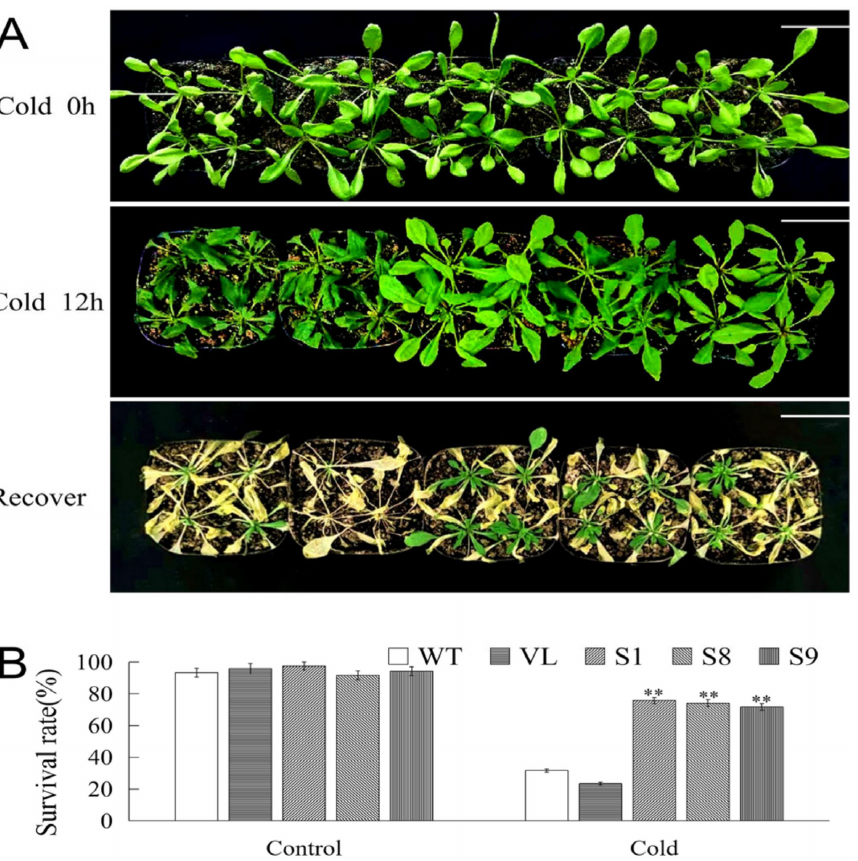
Figure 7. Overexpression of MbICE1 improves cold resistance of plants. ( A ) Phenotypes of WT, VL, (vector line) and overexpression- MbICE1 under Cold 0 h, Cold 12 h, and recover growth. The white scale represents 3 cm. ( B ) Survival rates of WT, VL, and overexpression- MbICE1 after Cold 0 h and Cold 12 h. The value is the average of three repeats, and the standard deviation is represented by the error bar. The asterisk indicates the difference compared to WT (** p ≤